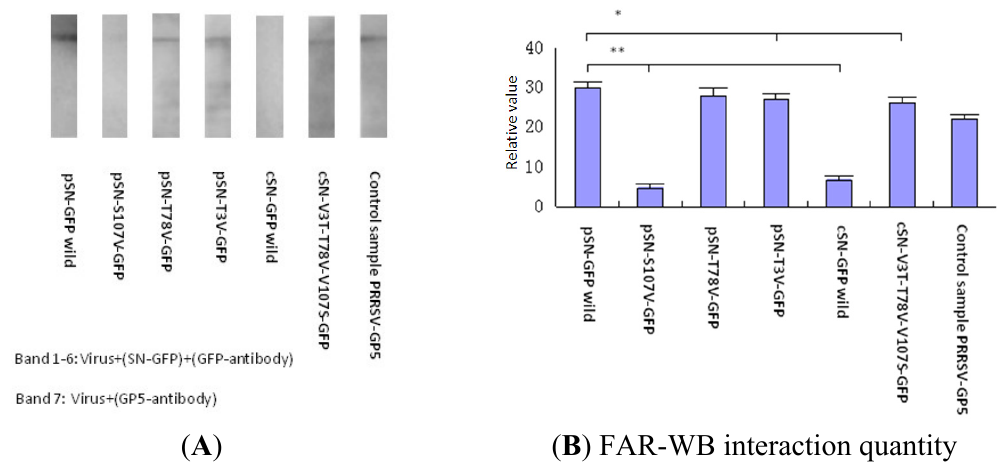
Figure 5. Binding activity analysis of SN-GFP proteins to PRRSV-GP5 using FAR-WB. ( A ) Binding activity of the six SN-GFP proteins with PRRSV-GP5 was tested using FAR-WB using a GFP-tagged antibody (bands 1–6). PRRSV-GP5 control samples were probed with anti-PRRSV-GP5 antibody (band 7); and ( B ) Binding activity of the six SN-GFP proteins with PRRSV-GP5 using FAR-WB. * significance; ** very